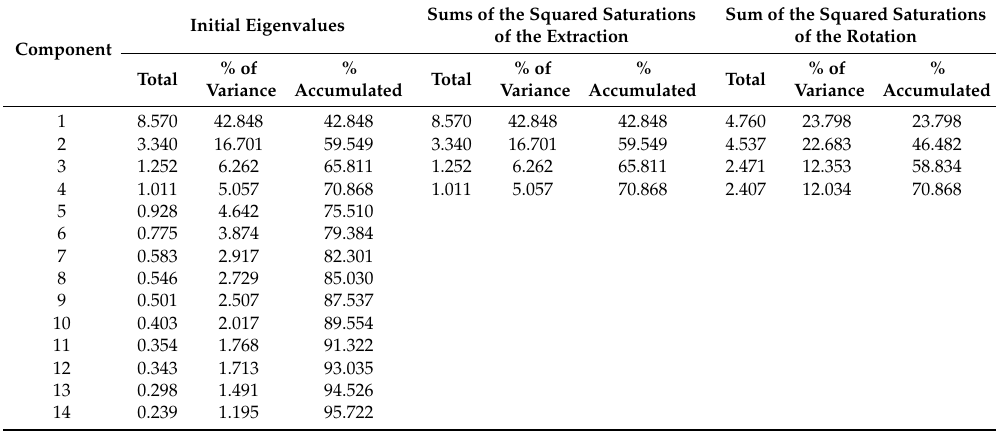
Table 2. Explained variance of the 20-item Joint Assessment of Equilibrium and Neuro-motor Function (JAEN) screening tool items by principal component